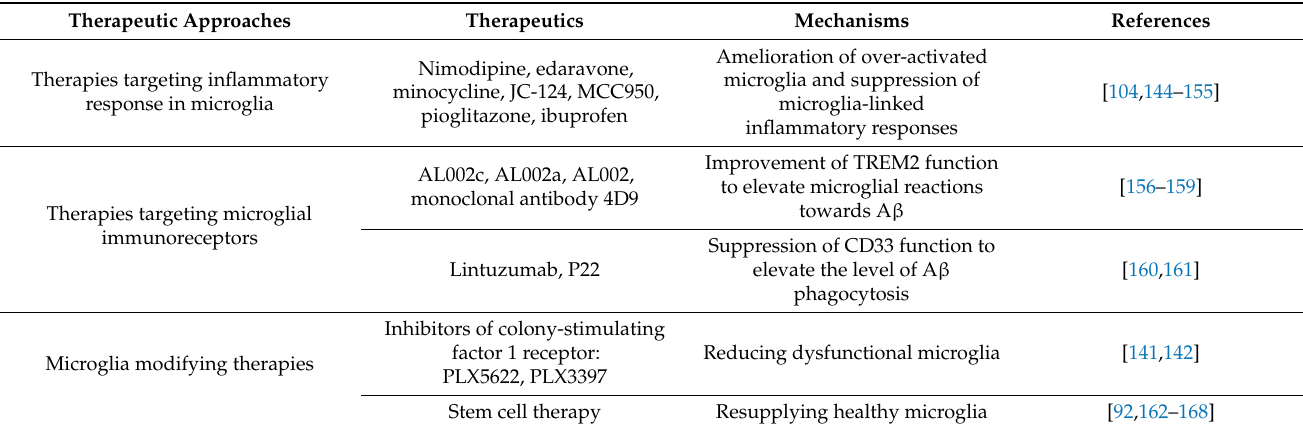
Table 3. Microglial drug targets in Alzheimer’s disease treatment